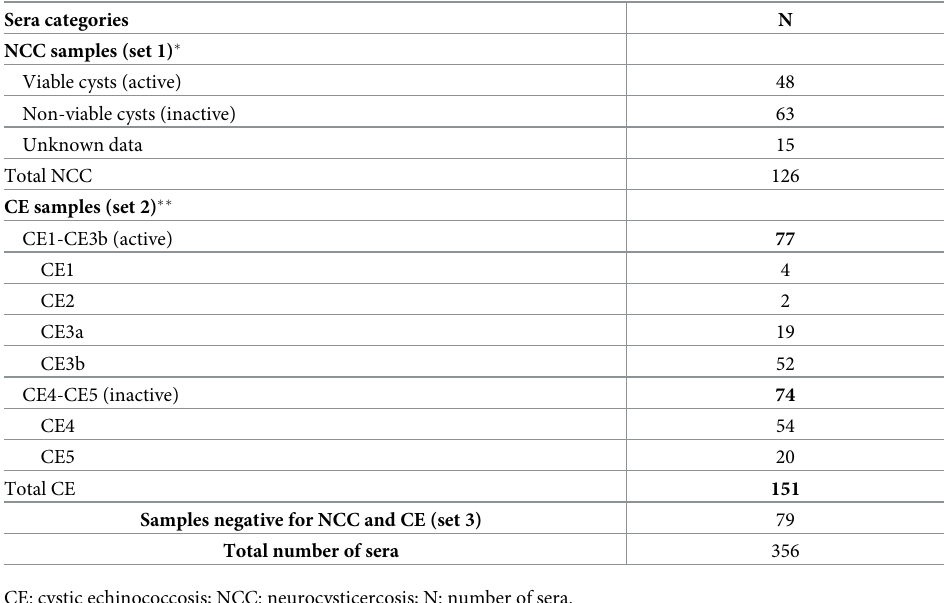
Table 1. Sample collection. Characteristics and number of tested serum samples. Sera